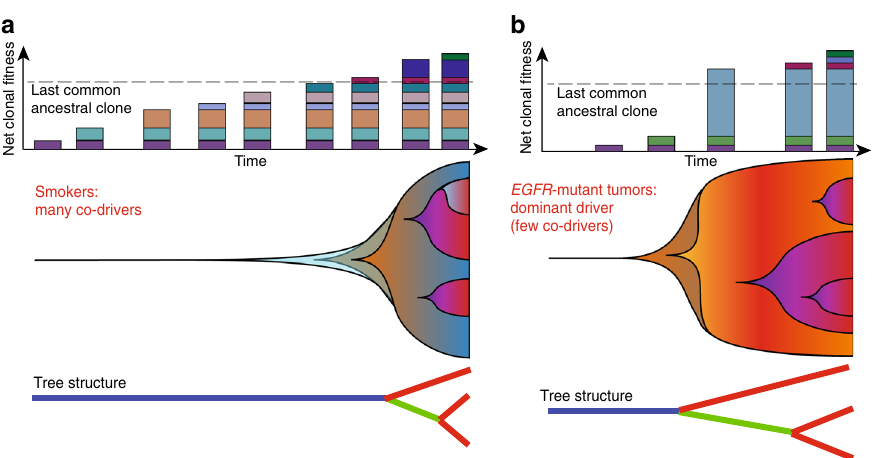
Fig. 5 Schematic of evolutionary trajectories in smokers and EGFR -mutant non-smoker tumors. a In smokers, accumulation of many truncal mutations and drivers before branched evolution. Top: driver mutations are represented as colored rectangles. The dashed line indicates the point of diversi fi cation on the tree or the last common ancestral clone (carrying the last truncal driver mutation). Middle: shaded background represents clonal expansion ( y -axis) as mutations accumulate ( x -axis) in individual clones (colors). Bottom: schematic representation of phylogenetic mutation tree. b The non-smoker scenario where a dominant driver like EGFR is hit early leading to a big fi tness advantage, fewer clonal sweeps and early diversi fi cation. Panel structure as in a . In both scenarios, evolutionary trajectory is in fl uenced by clonal dynamics, which in turn is related to competitive fi tness of the individual cell populations. Example of such factors include but are not limited to mutations rates, driver nature, cytokine milieu, immune cell in fi ltration, and metabolic